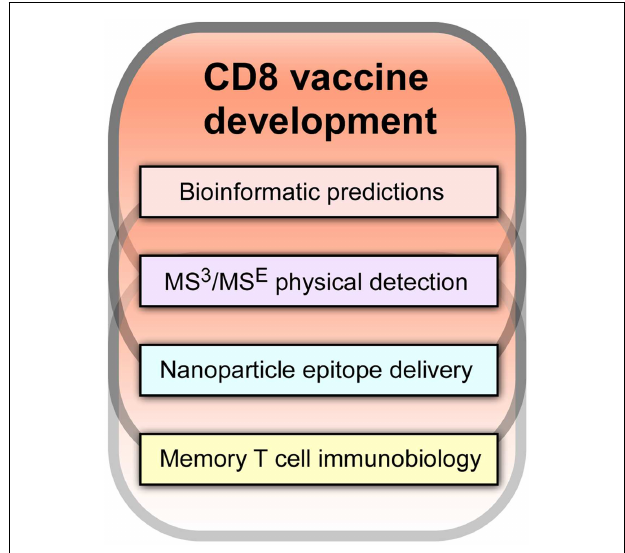
FIGURE 1 | Essential components of efficacious CD8 vaccine development